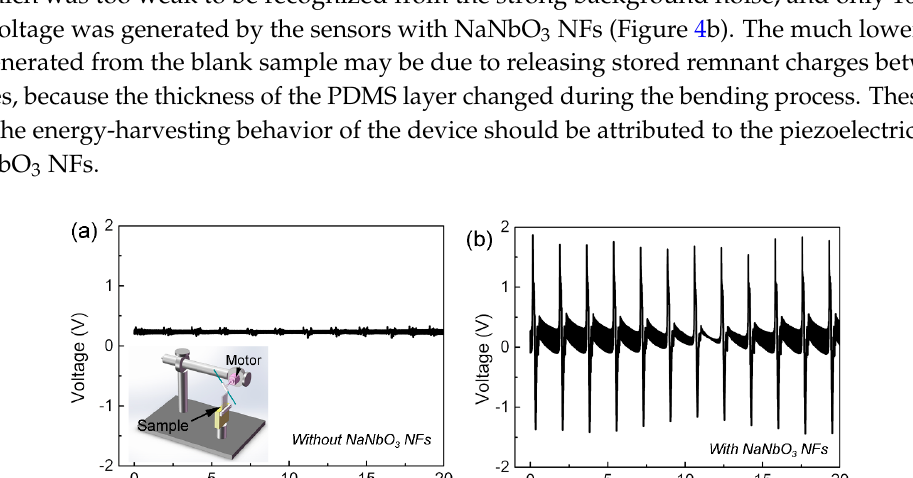
Figure 3. NaNbO 3 NF-based active sensors fabrication